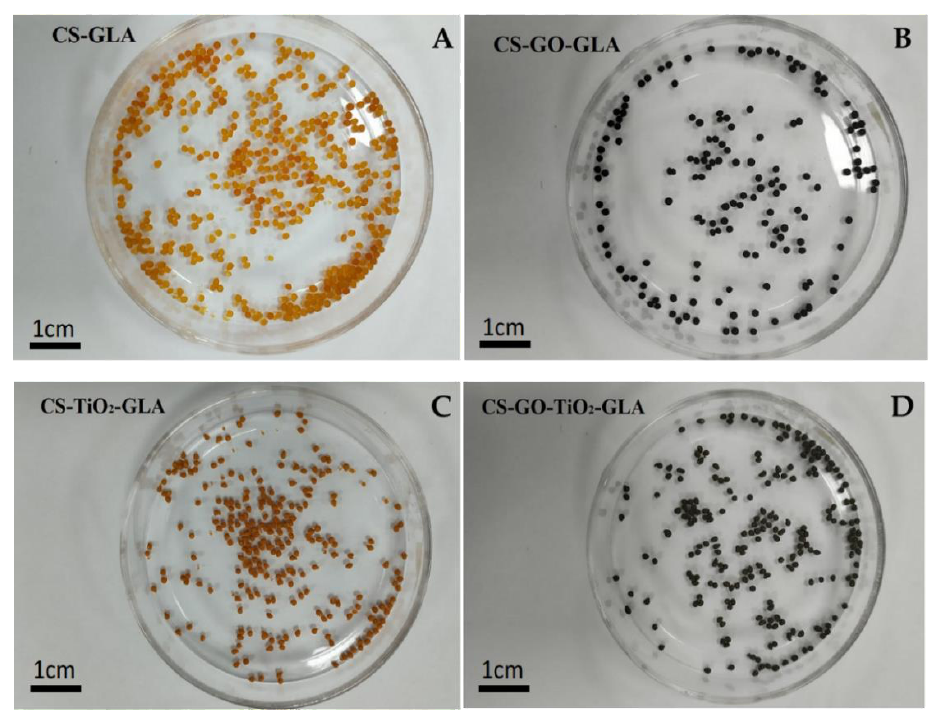
Figure 6. Images of the different bead composites: ( A ) CS-GLA, ( B ) CS-GO-GLA, ( C ) CS-TiO 2 -GLA, ( D ) CS-GO-TiO 2 -GLA.